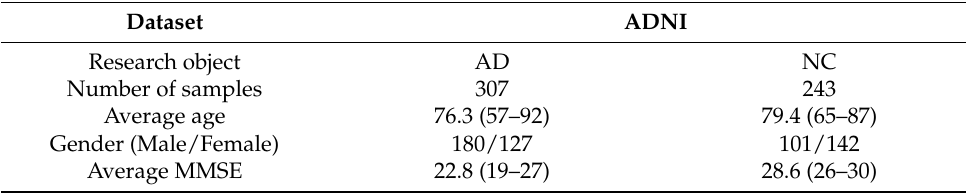
Table 1. Detailed information of the experimental